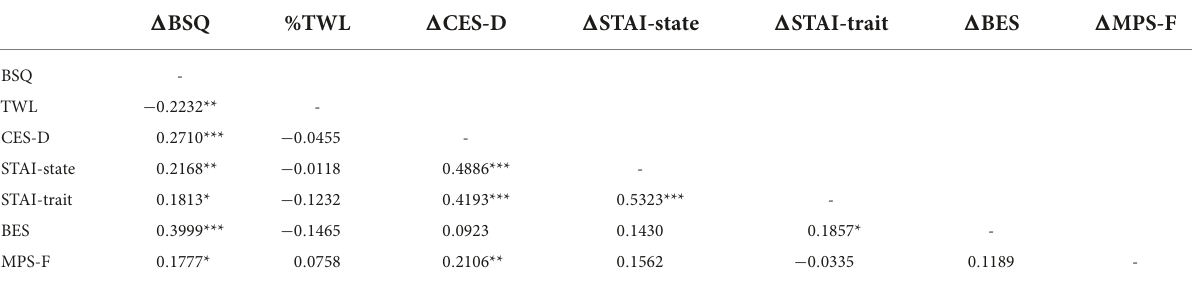
TABLE 3 Correlations between (cid:49) BSQ and change in clinical